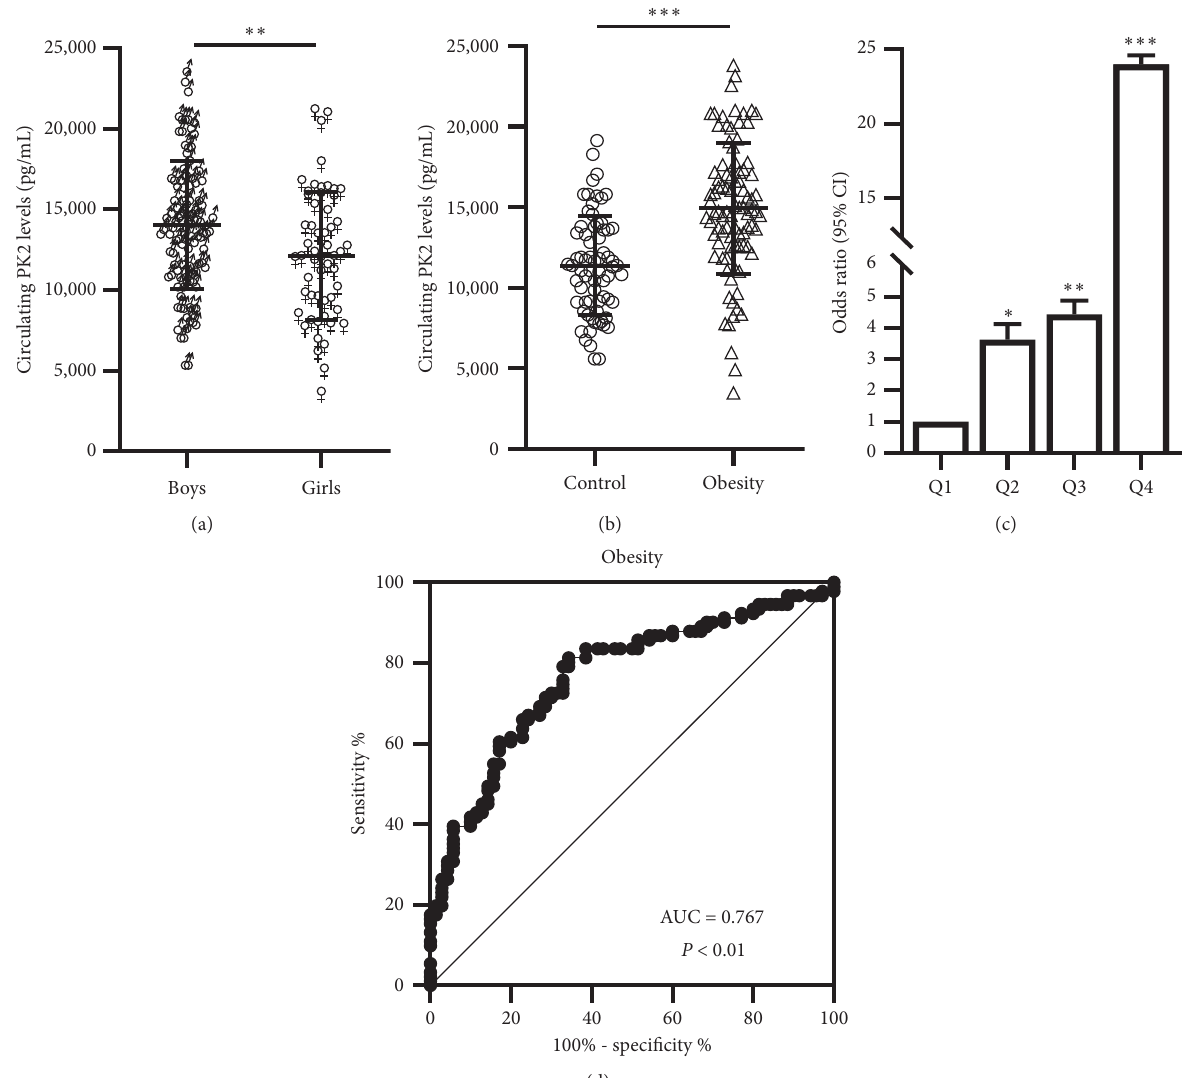
Figure 1: Circulating PK2 levels and ROC curve analysis in the study cohort. (a) Circulating PK2 levels in boys and girls (vs. boys: ∗∗ P < 0.01). (b) Circulating PK2 levels in children with obesity and normal-weight controls (vs. control: ∗∗∗ P < 0.001). (c) Prevalence of elevated obesity in different quartiles of PK2: quartile 1, < 10654.9pg/mL; quartile 2, 10654.9–13540.1pg/mL; quartile 3, 13540.1–15857.4pg/ mL; quartile 4, > 15857.4 pg/mL (vs. quartile 1: ∗ P < 0.05, ∗∗ P < 0.01, ∗∗∗ P < 0.001). (d) ROC curve analyses for the prediction of obesity according to the PK2